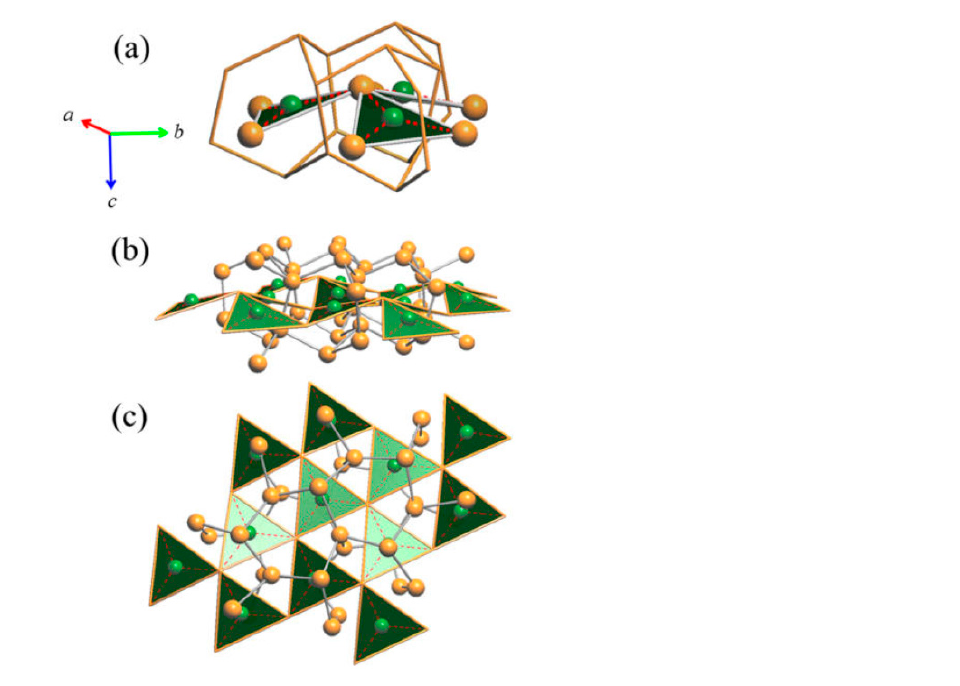
Figure 5. ( a ) Three triangular units sharing one vertex. ( b ) Perspective view of a layer formed by the ‘Cu 3 As’-triangular units. ( c ) Top view of the layer shown in ( b ). Note: for simplicity, in ( b ) and ( c ) the Cu atoms at the vertices of the ‘Cu 3 As’ units (Cu4–Cu1–Cu4) are not shown. Orange and green balls indicate Cu and As atoms, respectively. Table 4. Interatomic distances corresponding to the first coordination sphere for d obs / Σ r M ≤ 1.16 in Cu 2.882(1) As, as obtained from single crystal